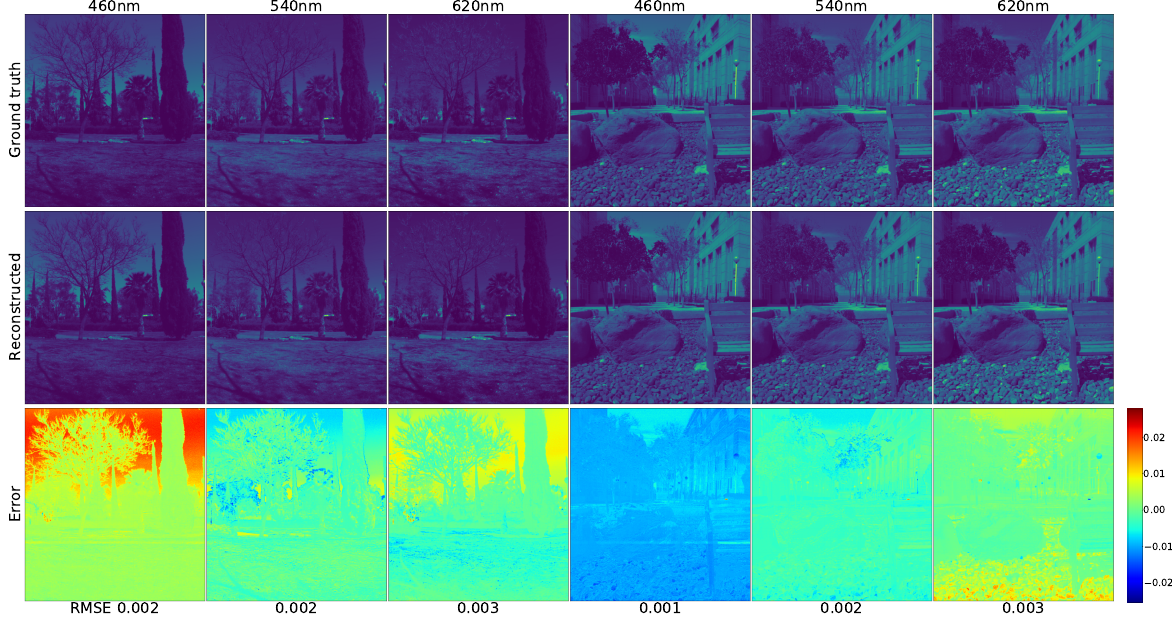
Figure 11. The effects of reconstructing the 3 chosen ICVL spectrum bands from the 2 scenes. (The two original input RGB images are shown in the top-left 2 images of Figure 12.)